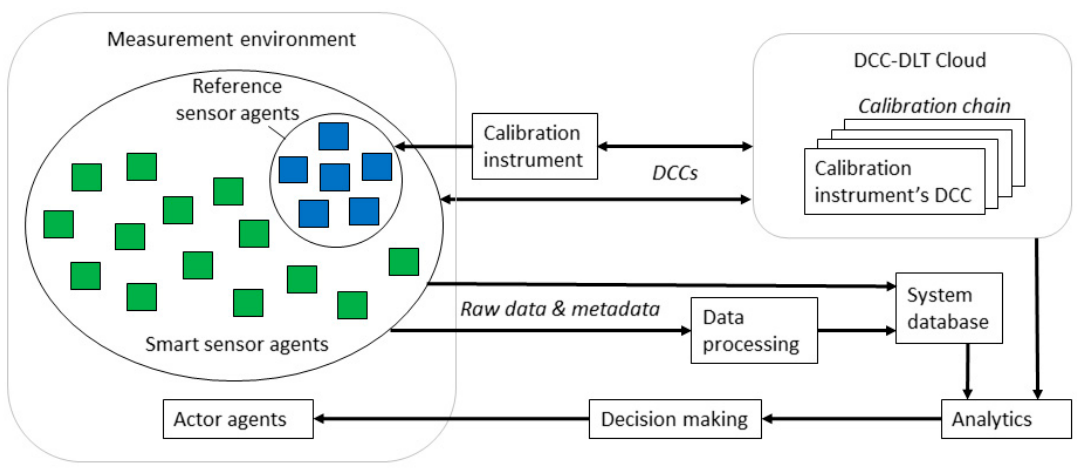
Figure 5. An example architecture for a sensor network system using DCC-validated measurement data.